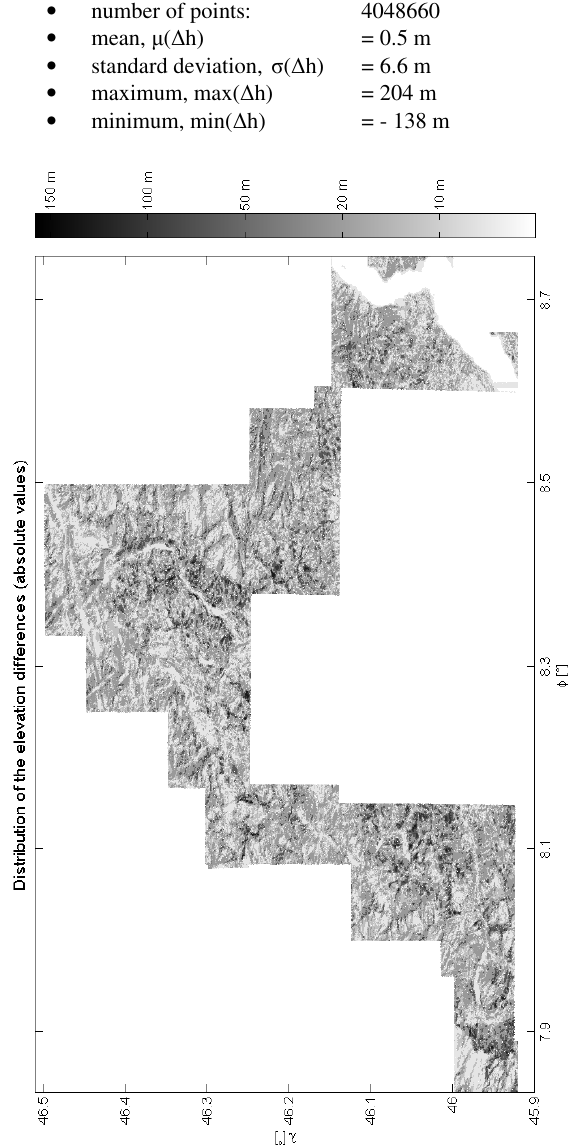
Figure 4. Spatial distribution of the elevation differences between Switzerland and Piedmont